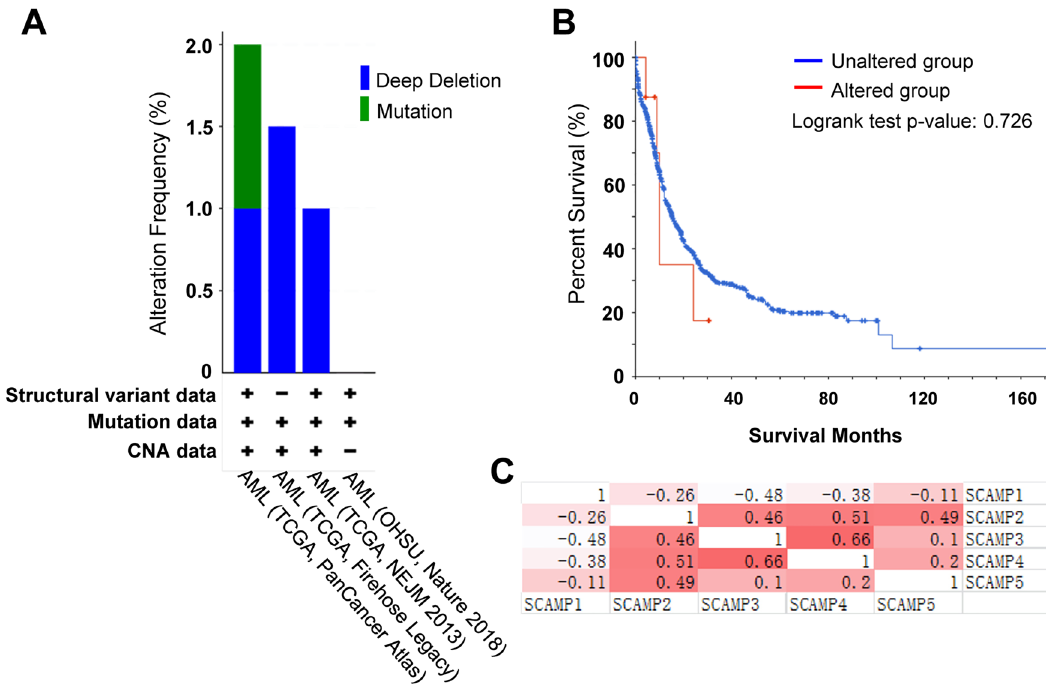
Figure 1. Alteration frequency of SCAMP genes has no significant correlation with AML prognosis (TCGA and cBioPortal). ( A ) OncoPrint visualization of alterations associated with SCAMPs genes. ( B ) Survival percentage and survival time of AML patients with/without gene alterations by Kaplan–Meier plots. ( C ) Correlation between the mRNA expression of different SCAMPs in AML